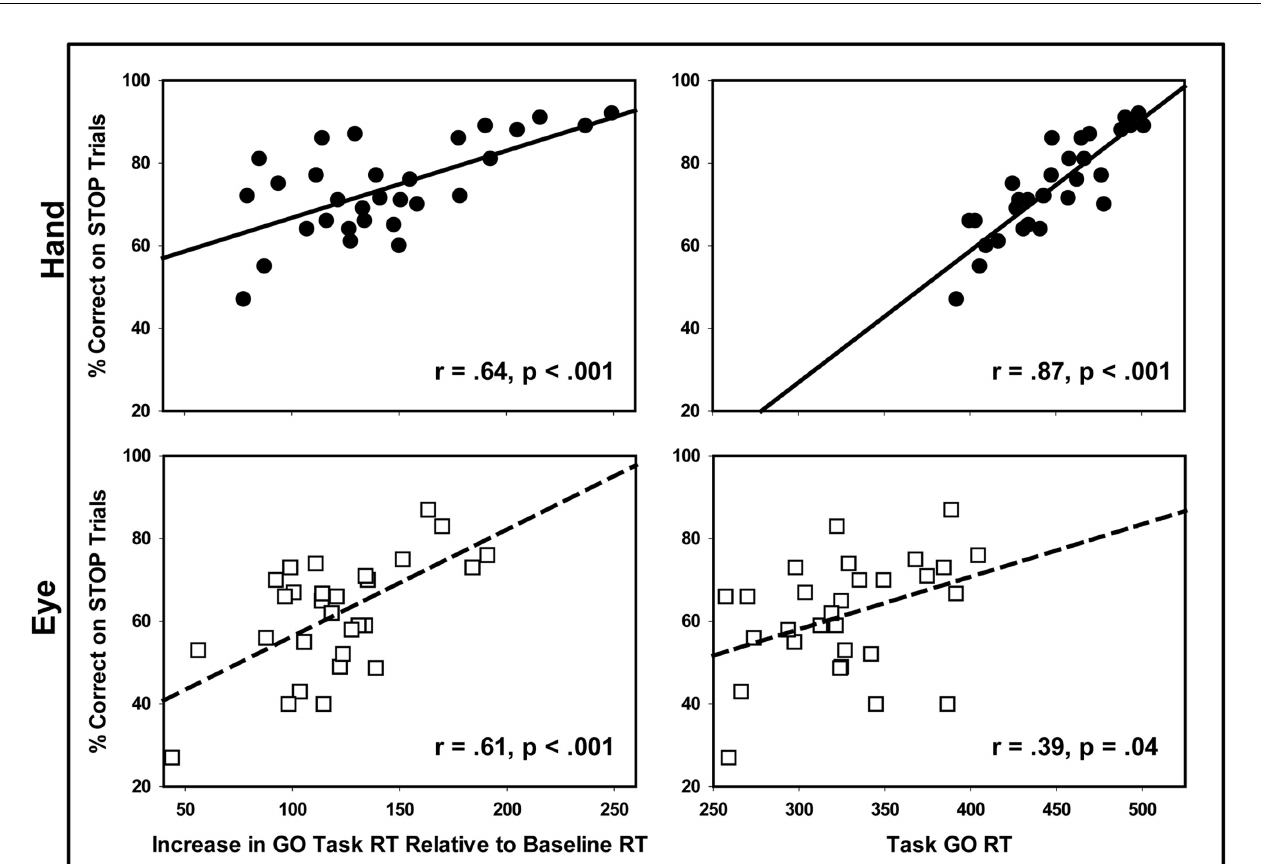
FIGURE 4 | Relationships between reaction times for Stop Signal test GO trials and STOP trial accuracy for the eye and hand. Longer GO trial reaction times during the Stop Signal test were associated with increased rates of stopping accuracy for both eye and hand movements. The strength of this relationship was greater for hand than eye